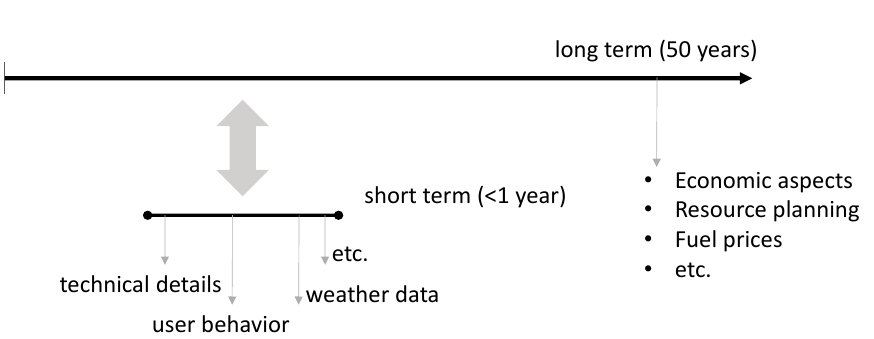
Figure 1. Representation of the main scalability issues: time resolution and heterogeneity. 4. Uncertainty